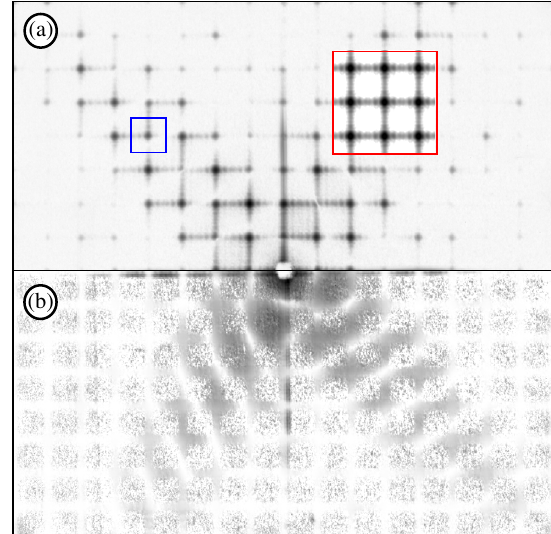
FIG. 6. Extracted unit-cell transforms (on a logarithmic scale) and corresponding unit-cell density reconstructions (linear scale, without an applied support). Iterative phasing was performed on re-binned intensity maps, rather than the finely sampled maps shown here. The gridlike appearance of regions with large errors is caused by the lack of a strong diffraction signal in those regions. Only the intensities where either of the Miller indices are nearly integer-valued were used as Fourier-amplitude constraints, while the remaining intensities with larger errors were allowed to float. Each of the reconstructions shown are the averages over 250 individual images, which were selected from the total of 500 phasing trials via pairwise